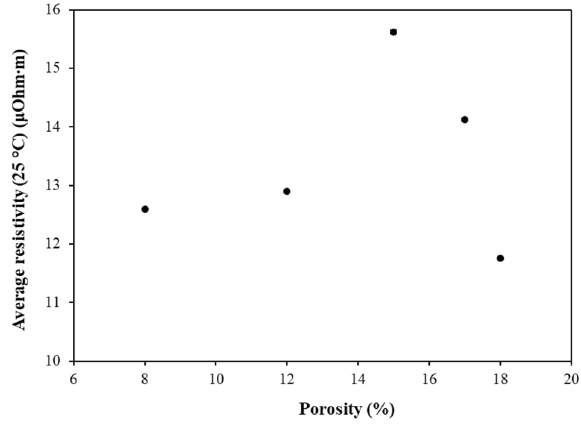
Fig. 5 Variation in average resistivity at room temperature with amount of porosity in the